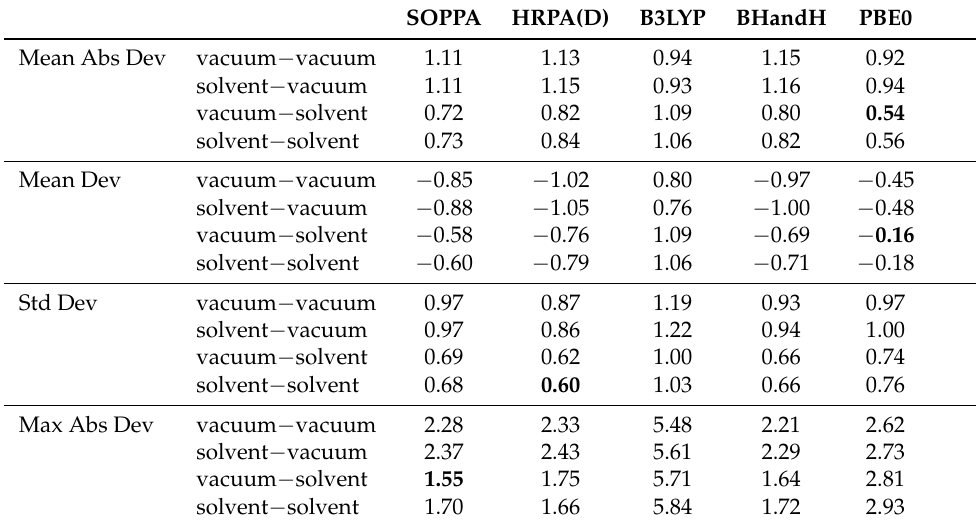
Figure 4. The statistics for the 29 2 J CH coupling constants. Table 4. Statistical data for the 2 J CH